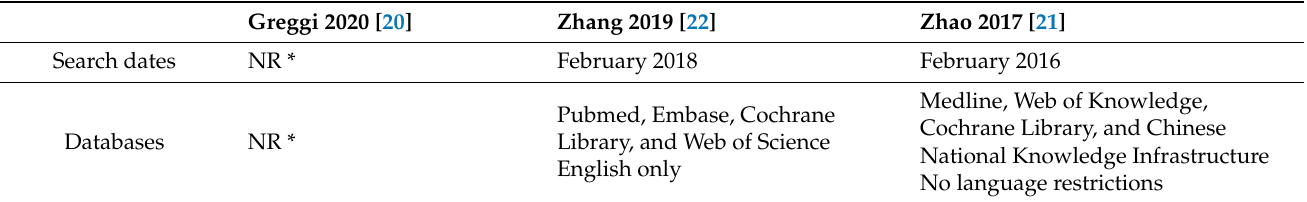
Table 1. Overview of included